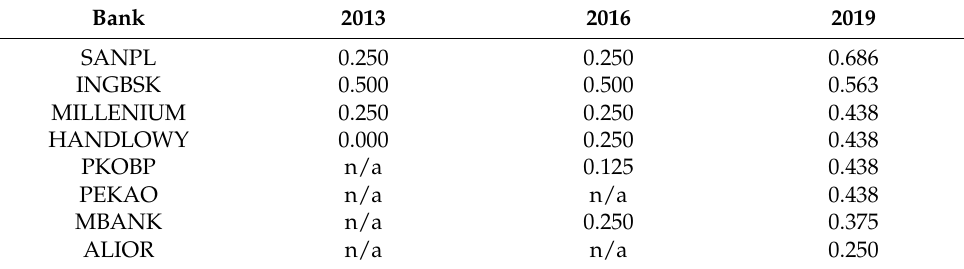
Table 4. The BEB index: total values for the sample banks.